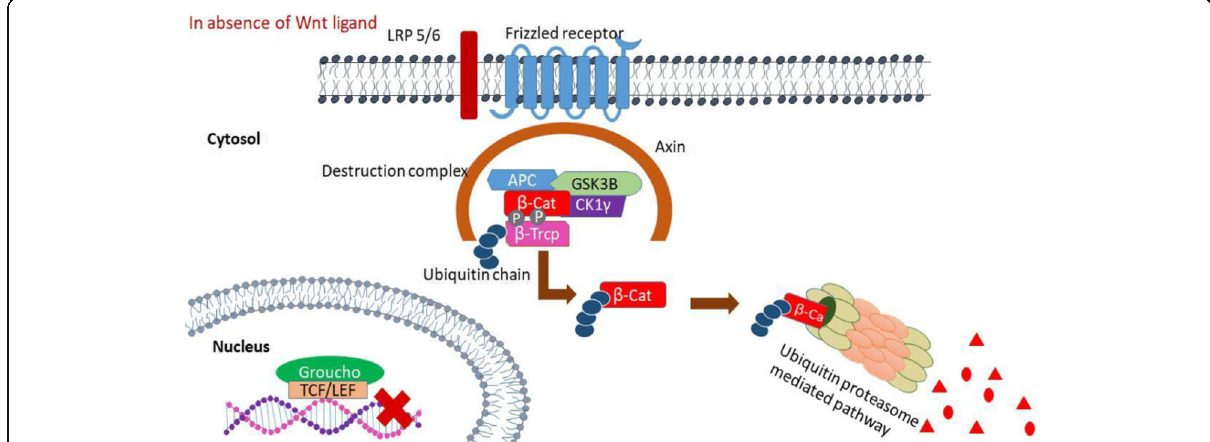
Fig. 1 In the absence of Wnt proteins, Axin, APC, β -catenin, and GSK3B form a complex, in which β -catenin is phosphorylated by CK1 and GSK3B, leading to β -catenin degradation via ubiquitin proteasome-mediated